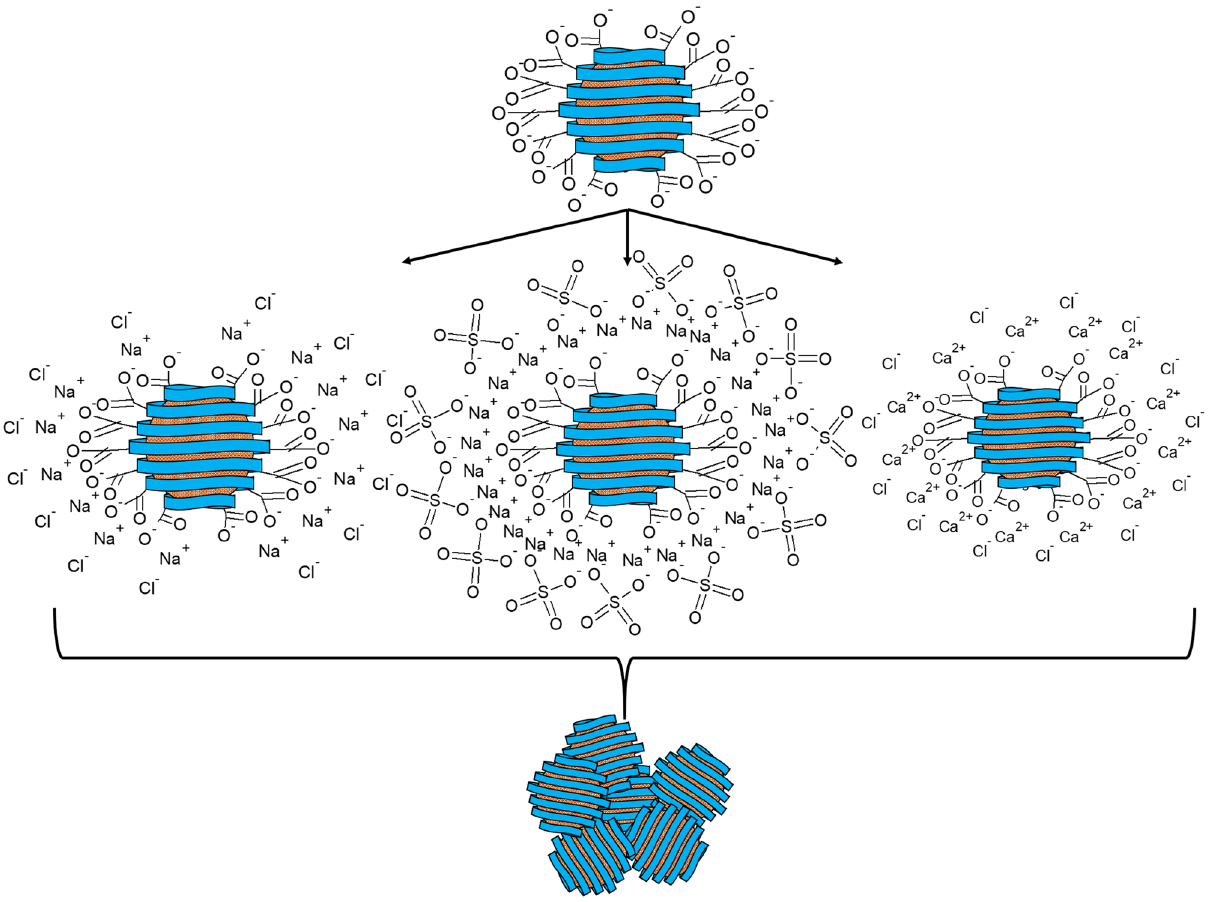
Figure 16. Scheme of CuO nanoparticles coagulation by various